Question: Express in one sentence what the figure is showing.
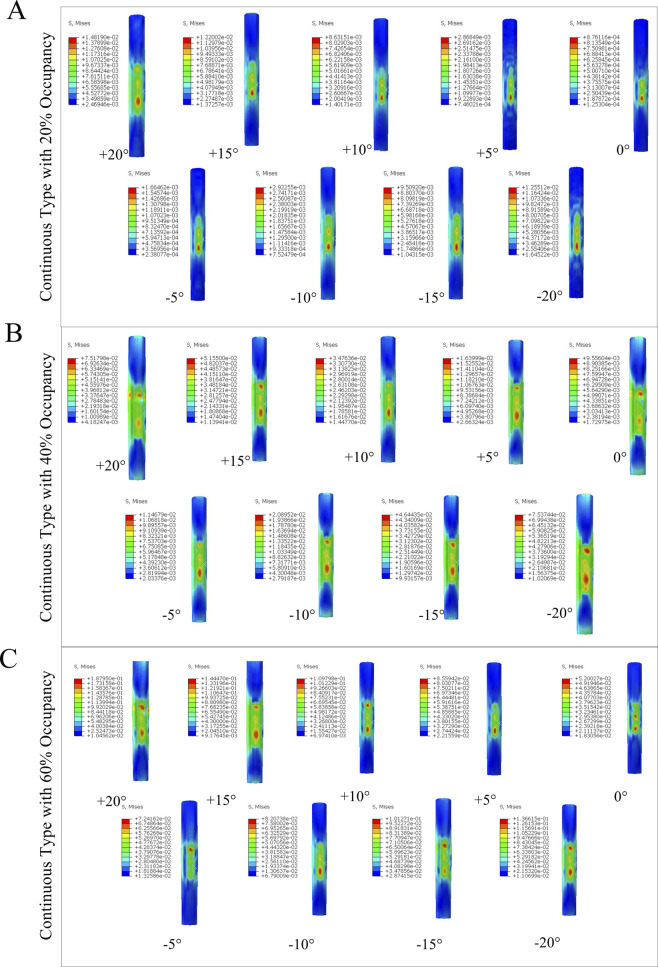
Answer: Von Mises stress distribution contours in the spinal dura mater under different spinal canal occupancy rates and flexion-extension angles for continuous C-OPLL. (A) Occupancy rate 20%; (B) Occupancy rate 40%; (C) Occupancy rate 60%. Angles in sequence: extension 20°, 15°, 10°, 5°, neutral 0°, flexion 5°, 10°, 15°, 20°. Stress scale unit: MPa.